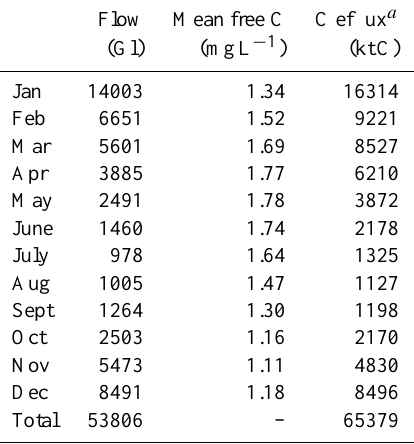
Table 6. Summary of monthly predictions across all of England and Wales for total flow volume (gigalitres; GL) based on composite runoff (Fekete et al., 2002) on a 0.5 ◦ resolution grid, mean concen- tration of free CO 2 -C (mgL − 1 ) and potential carbon efflux (kilo- tonnes